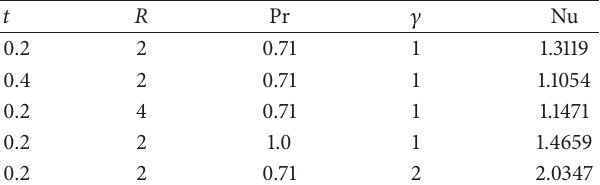
Table 2: Nusselt number variation.